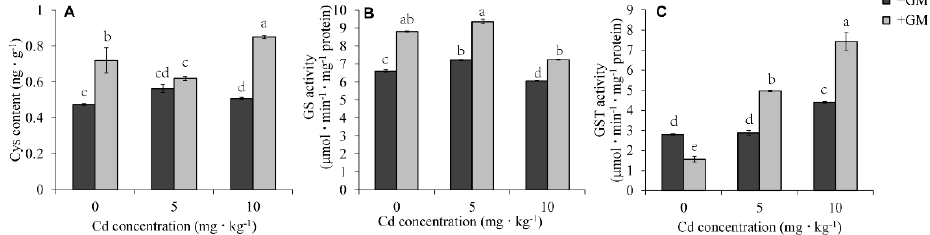
Figure 9. Effects of AMF on Cys content ( A ) and GS and GST activity ( B , C ) under different Cd concentrations. Values are the means ± standard deviation (SD) ( n = 3). Different letters in the same column indicate statistically significant differences ( p < 0.05).